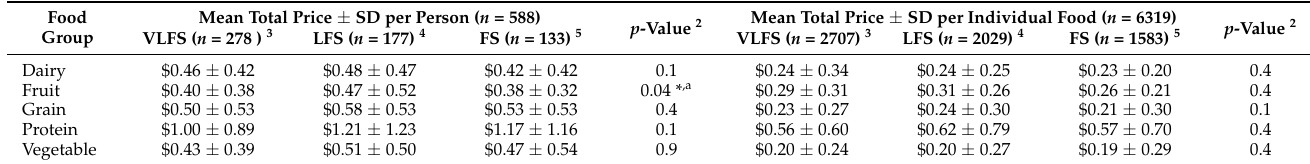
Table 3. Mean total prices for reported 24-h dietary intake by food group among adults using rural, Midwestern food pantries recruited in 2014 1 .